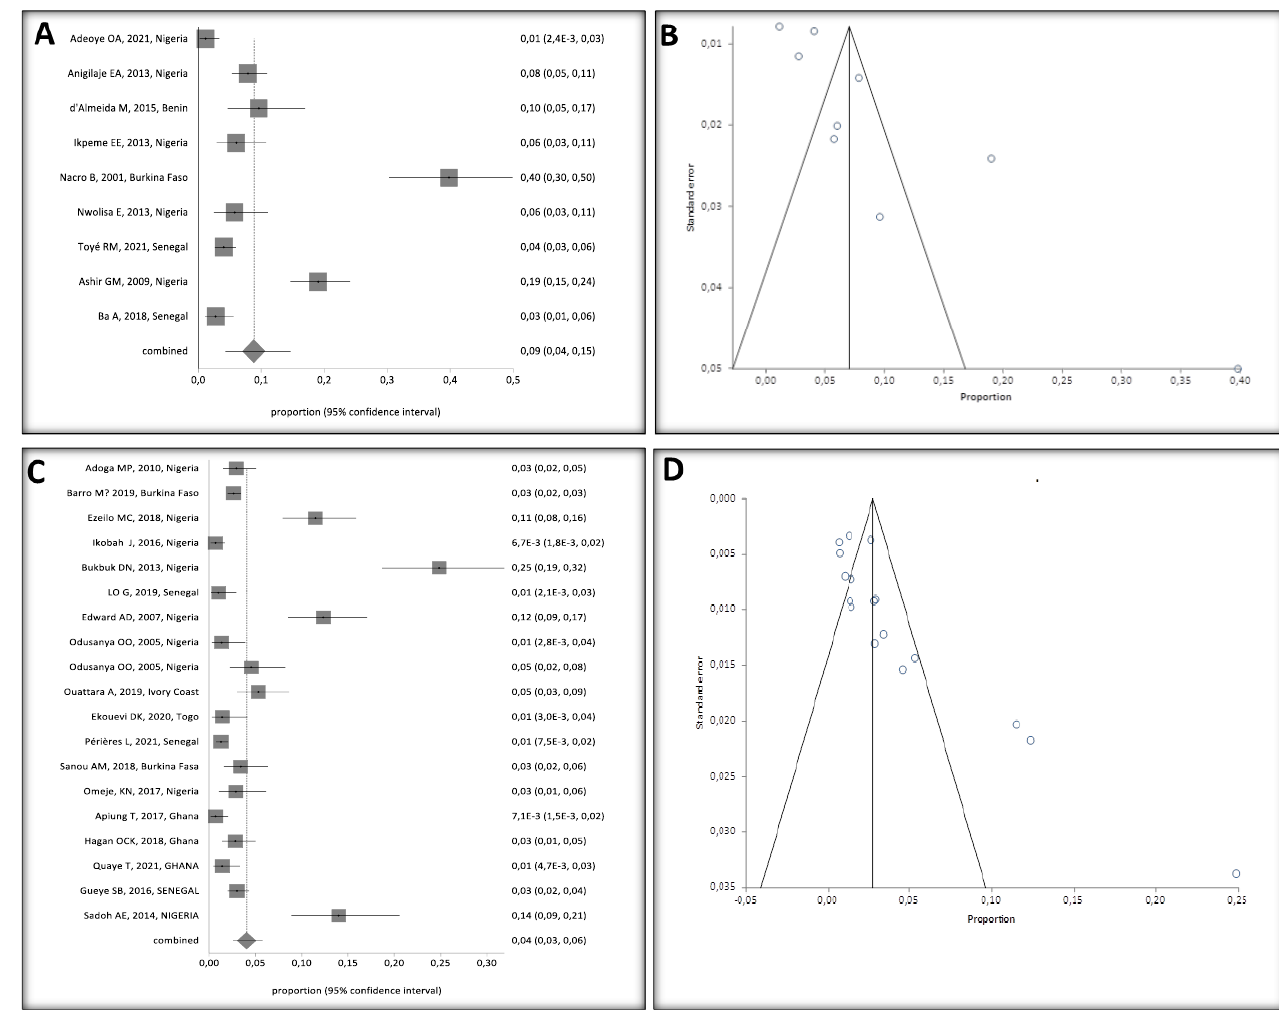
Figure 8. ( A ) Forest Plots of HBV/HIV Co-Infected Children, ( B ) Bias Assessment of Co-Infected Children, ( C ) Forest Plots of HBV Mono-Infected Children, ( D ) Bias Assessment of HBV Mono-Infected Children [24–34,36–40,42–45,47–50]. A black square represents the HBV prevalence in the forest plot. The square position represents the prevalence in each study in the meta-analysis. HBV Prevalence among Vaccinated and Unvaccinated Children HBV prevalence was still high in studies of unvaccinated children [6% (95%, CI: 4–8%)] (Figure 9A) compared to studies of vaccinated children [2% (95%, CI: 1–3%)] (Figure 9B). Due to a lack vaccination status data in most studies, HBV prevalence caused by natural infection (anti-HBs + anti-HBc) could not be evaluated.